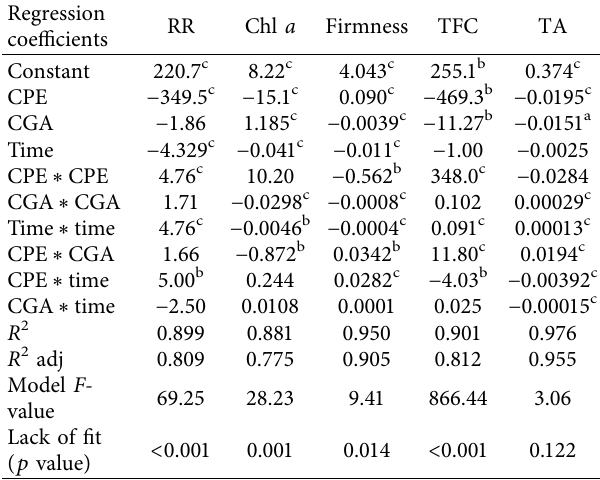
Figure 3: Response surface for ripening rate of coated tomato as function of concentration of pineapple peel extract and time of treatment. Table 3: Regression coefcients, R 2 , R 2 (adj), and probability values for four dependent